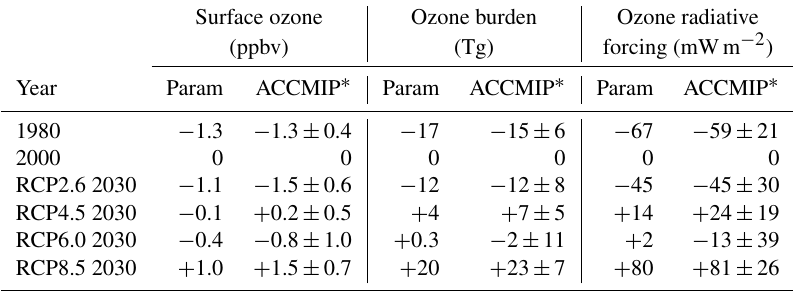
Table 10. The response in annual mean surface, global ozone burden and ozone radiative forcing in 1980 and for the CMIP5 emission scenarios in 2030 (relative to 2000) from the parameterisation (based on multiple models) and the multi-model mean value from ACCMIP ( ± 1SD of multi-model responses).